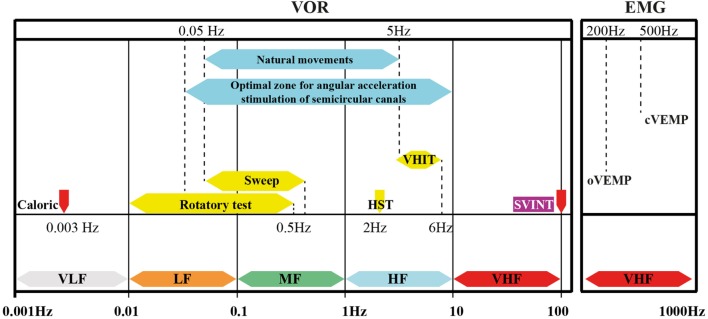
Vibration-induced nystagmus complements other vestibular tests in the vestibule multifrequency analysis. Place of the SVINT in the currently known frequency spectrum of the vestibular system. This graph summarizes the complementarity of vestibular tests, introduces the concept of the optimal vestibular compensation zone for the horizontal canal and the bone conduction stimulation frequencies necessary to obtain ocular vestibular-evoked myogenic potentials and cervical evoked myogenic potentials (cVEMP) (EMG). Adapted from Chays et al. (72) modified by Dumas (university PhD thesis 2014) (73). VLF, very low frequencies; LF, low F; MF, middle F: HF, high F; VHF, very high F.